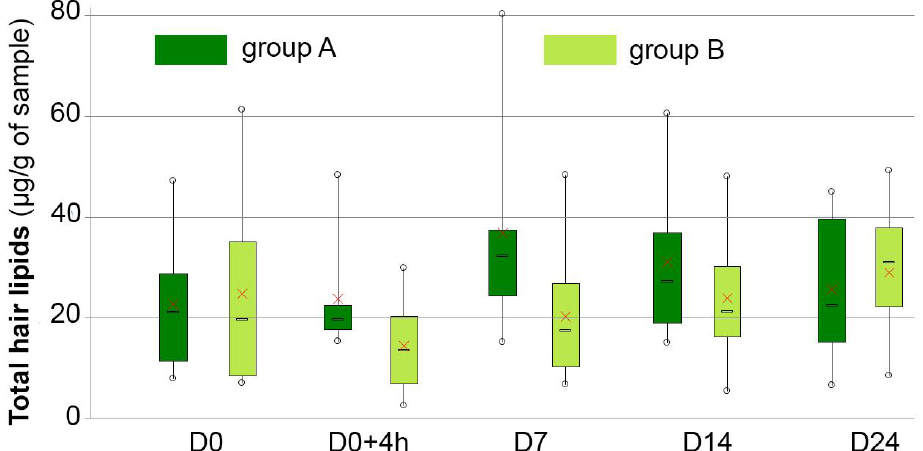
Figure 3. Kinetics of hair lipids in dogs with keratinization disorders that were washed in plain water (group A — dark green boxes) or received DOUXO ® S3 SEB shampoo and mousse (Ceva Santé Animale, France) (group B — light green boxes) at different time points during the study. Interpretation of the box and whisker plots: lower and upper box boundaries 25th and 75th percentiles, respectively, line inside box median, lower and upper whiskers minimum and maximum scores, respectively. X represents the mean.